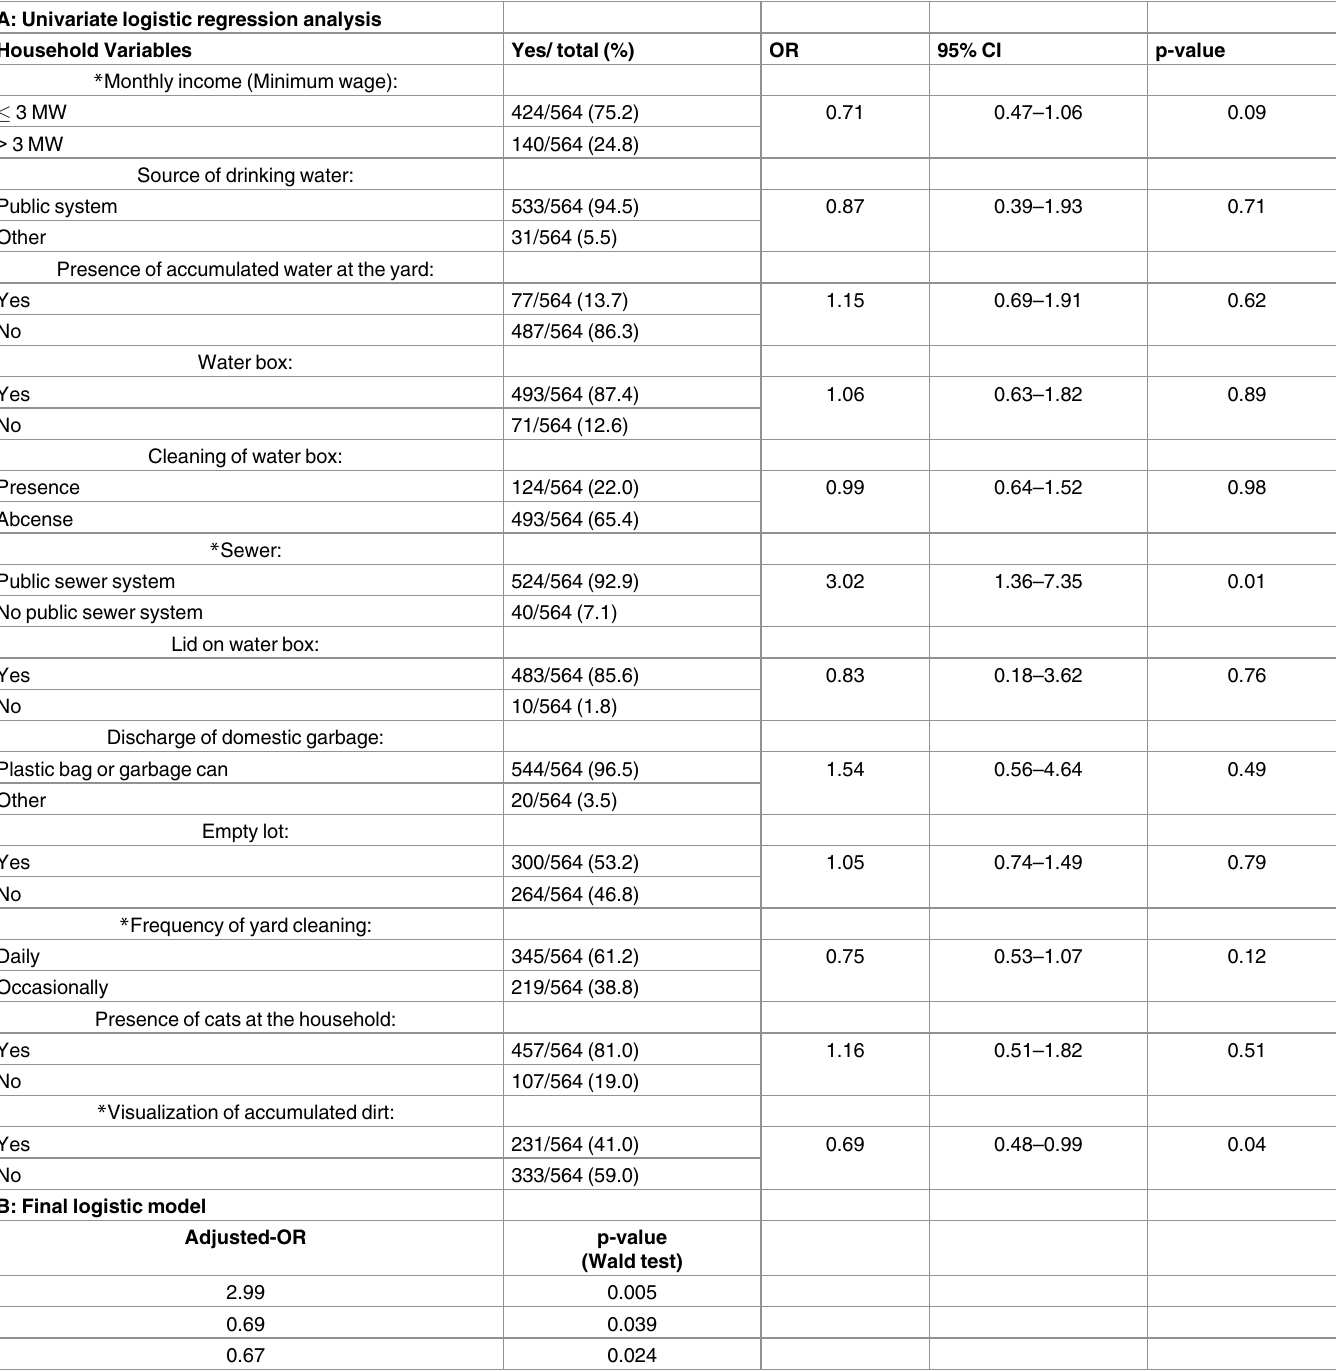
Table 1. Results of univariate logistic regression analysis of 564 households (owners or dogs) IgG anti- T . gondii antibodies detected by IFAT in the urban area of Londrina from July 2015 to July 2016. A: Univariate logistic regression